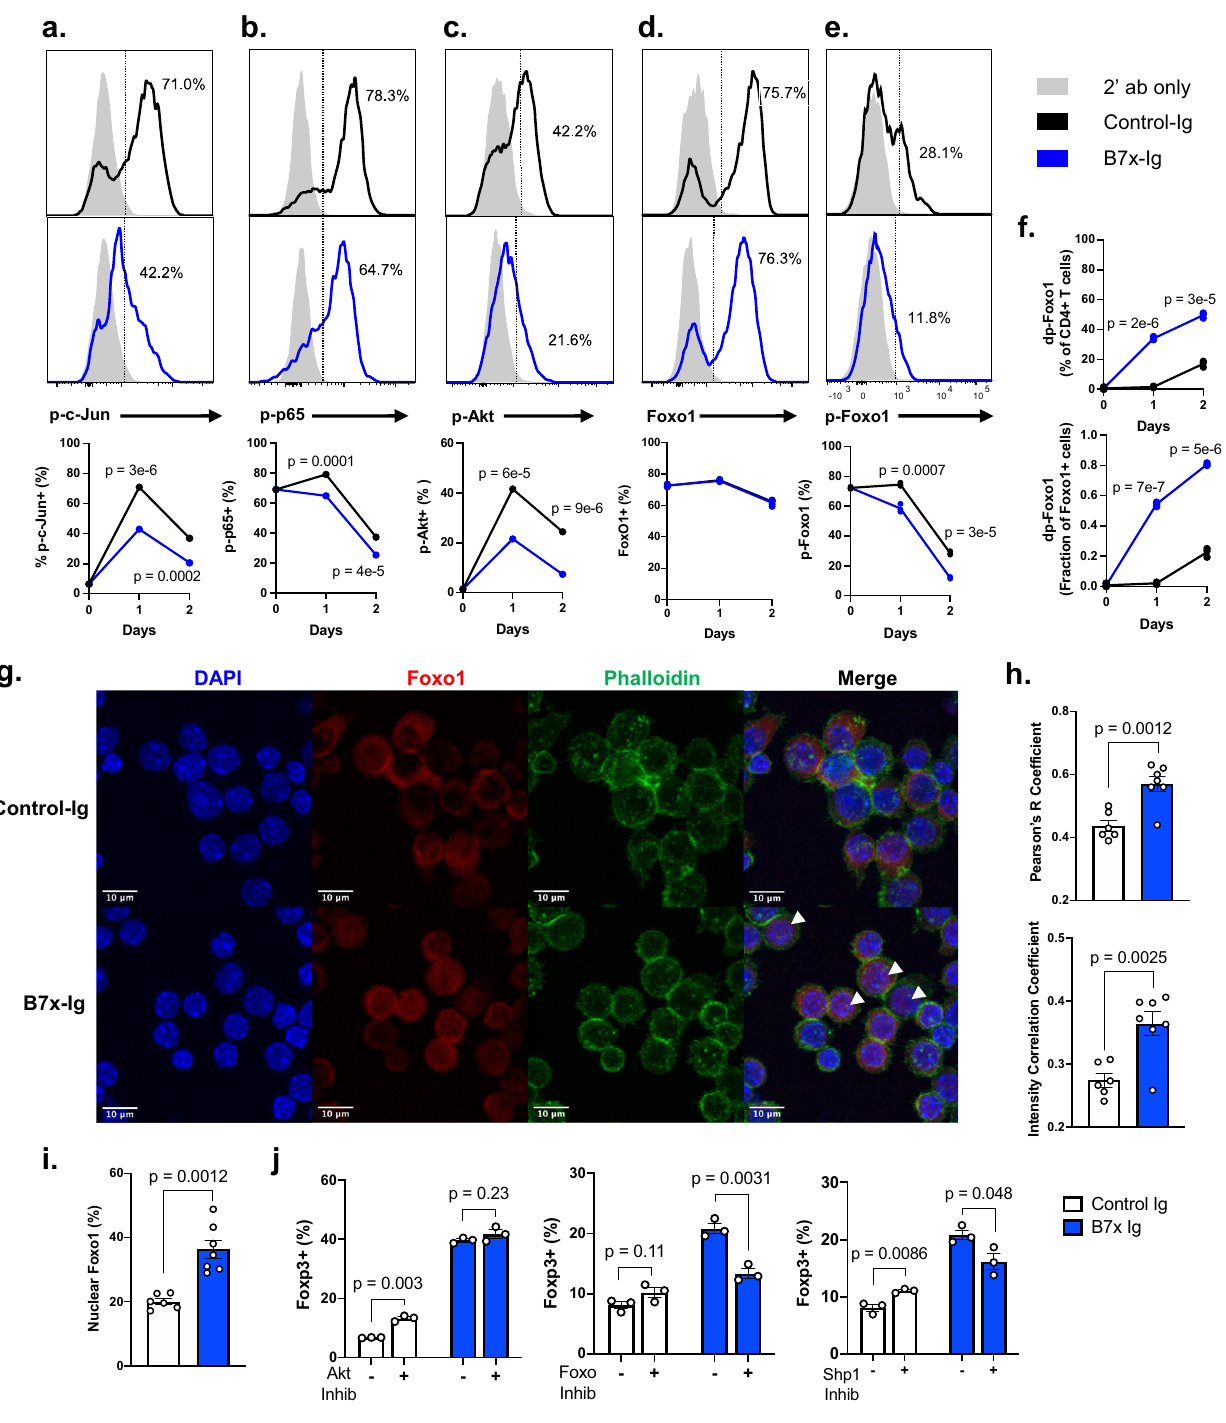
B7x tumors (Fig. 5f – h). We broadly pro fi led the tumor immune in fi ltrate and found that anti-CTLA-4 treatment generally increased effector T cell and NK cell populations in B7x + and B7x − tumors (Fig. 5f, g). In the myeloid compartment, we observed that anti-CTLA-4 treatment caused a shift of F4/80 + macrophages to F4/80 - Ly6C + monocytes in both tumor types (Fig. 5f, g). The effects of anti-CTLA-4 on cell populations was similar between MC38-B7x and MC38-Control tumors, with the notable exception of Tregs, which were not effectively depleted in MC38-B7x tumors (Fig. 5h). NATURE COMMUNICATIONS| (2022) 13:2506